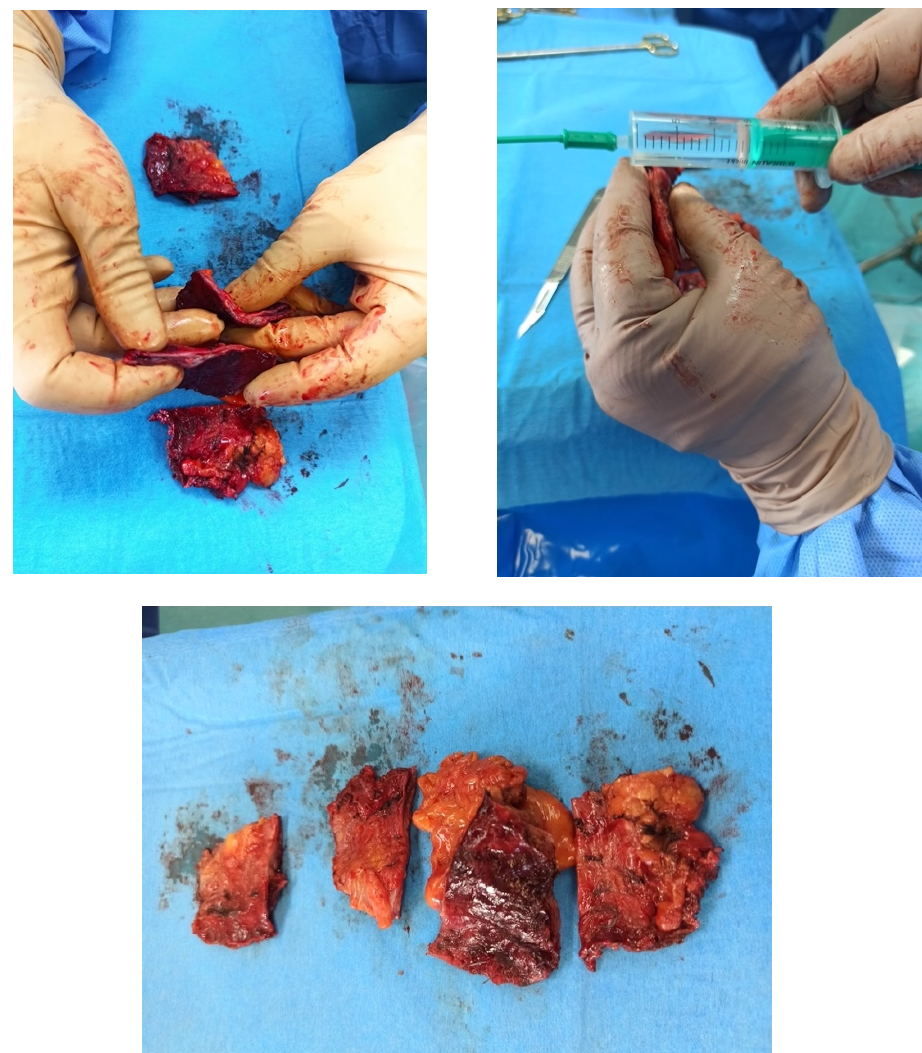
Figure 6. Gross pathological specimen of markedly thickened pericardium after pericardiectomy.